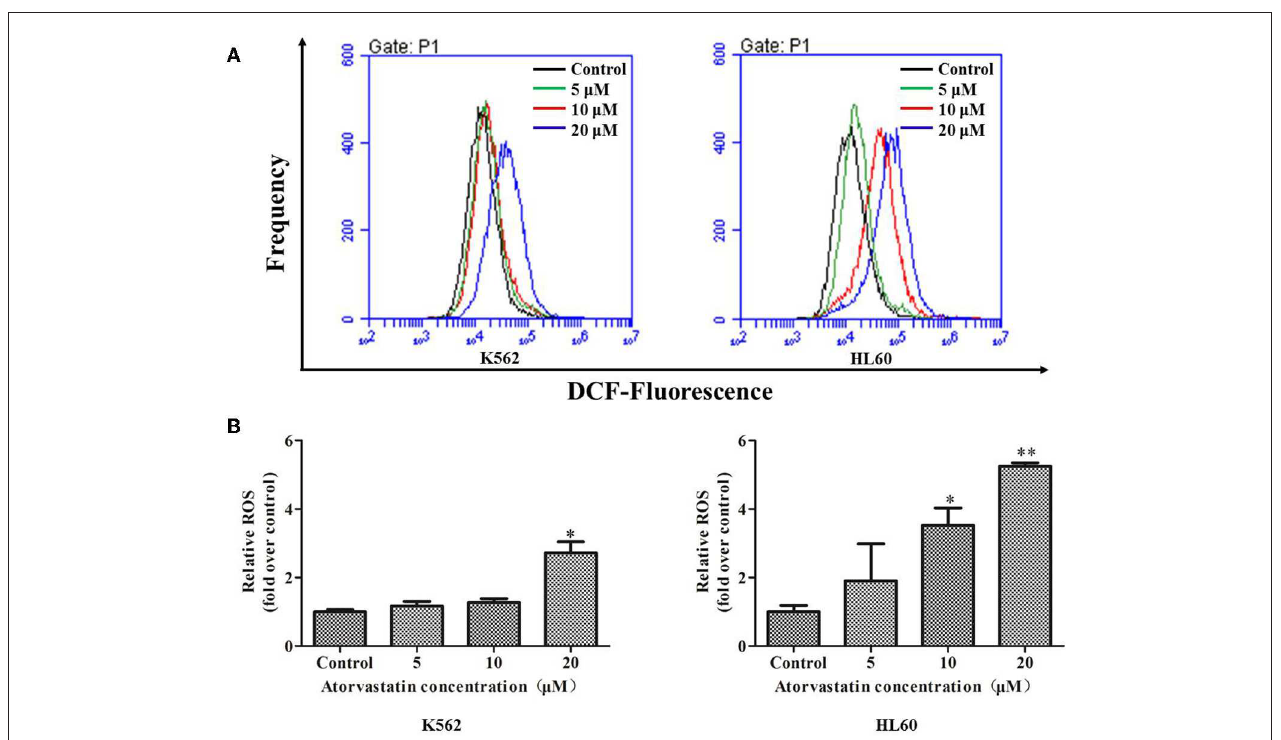
FIGURE 4 | Atorvastatin induces intracellular ROS generation in K562 and HL60 cells. K562 and HL60 cells were incubated with Atorvastatin (0, 5, 10, and 20 µ M) for 24h. (A) Intracellular ROS levels were detected by flow cytometer, and the representative images were shown. (B) The percentages of relative ROS were shown and statistically analyzed. Data are presented as mean ± SD of three independent experiments. * p < 0.05, ** p < 0.01 vs.